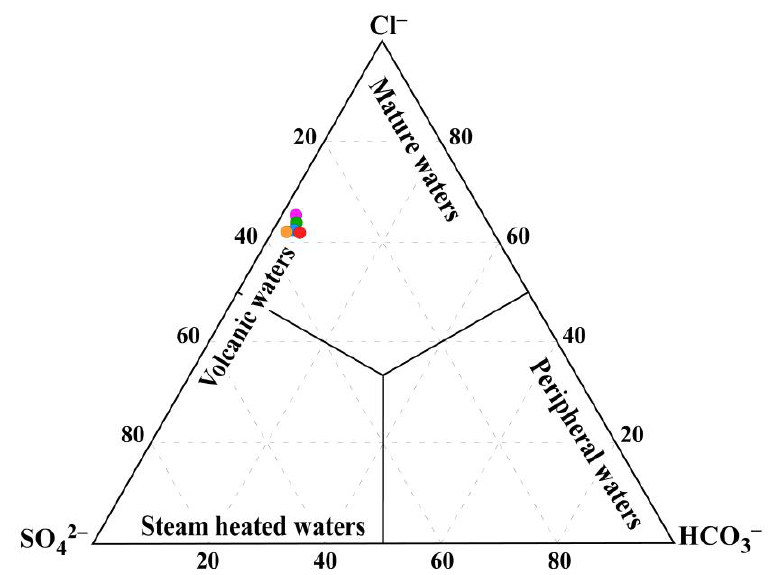
Figure 6. Triangular Cl − –SO 42 − –HCO 3 − diagram of [12] applied to the thermal waters of Goutitir, reported for a different date and from different authors ([5,14–16]; this work, 2019), (symbols as in Figure 4).